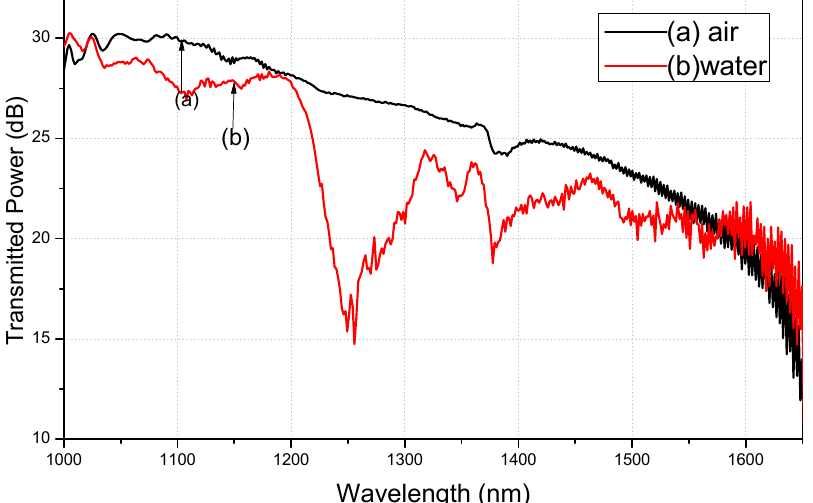
Figure 8. Transmitted power spectra of the silane coupling agent modified fiber tested in air and